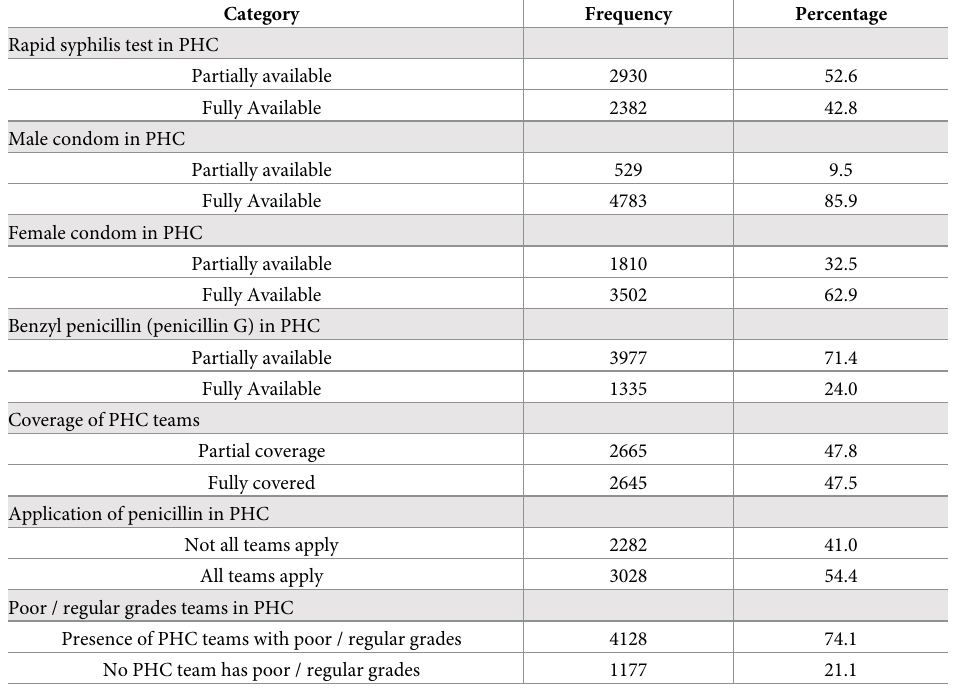
Table 2. Distribution of frequency and proportions of variables related to the basic health